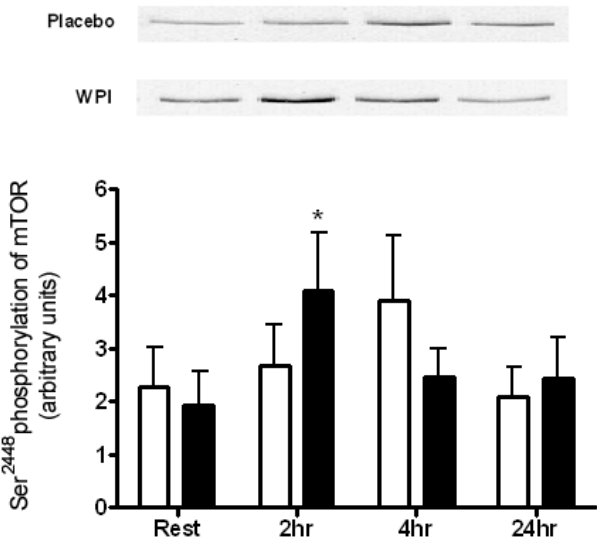
Figure 2 Phosphorylation of mTOR at Ser 2448 in human skeletal muscle at rest and 2, 4 and 24 h post-exercise during placebo and WPI trials. Values are arbitrary units (mean ± SEM; n=7 per trial). Open bars represent placebo, closed bars represent WPI. * P < 0.05 vs. resting